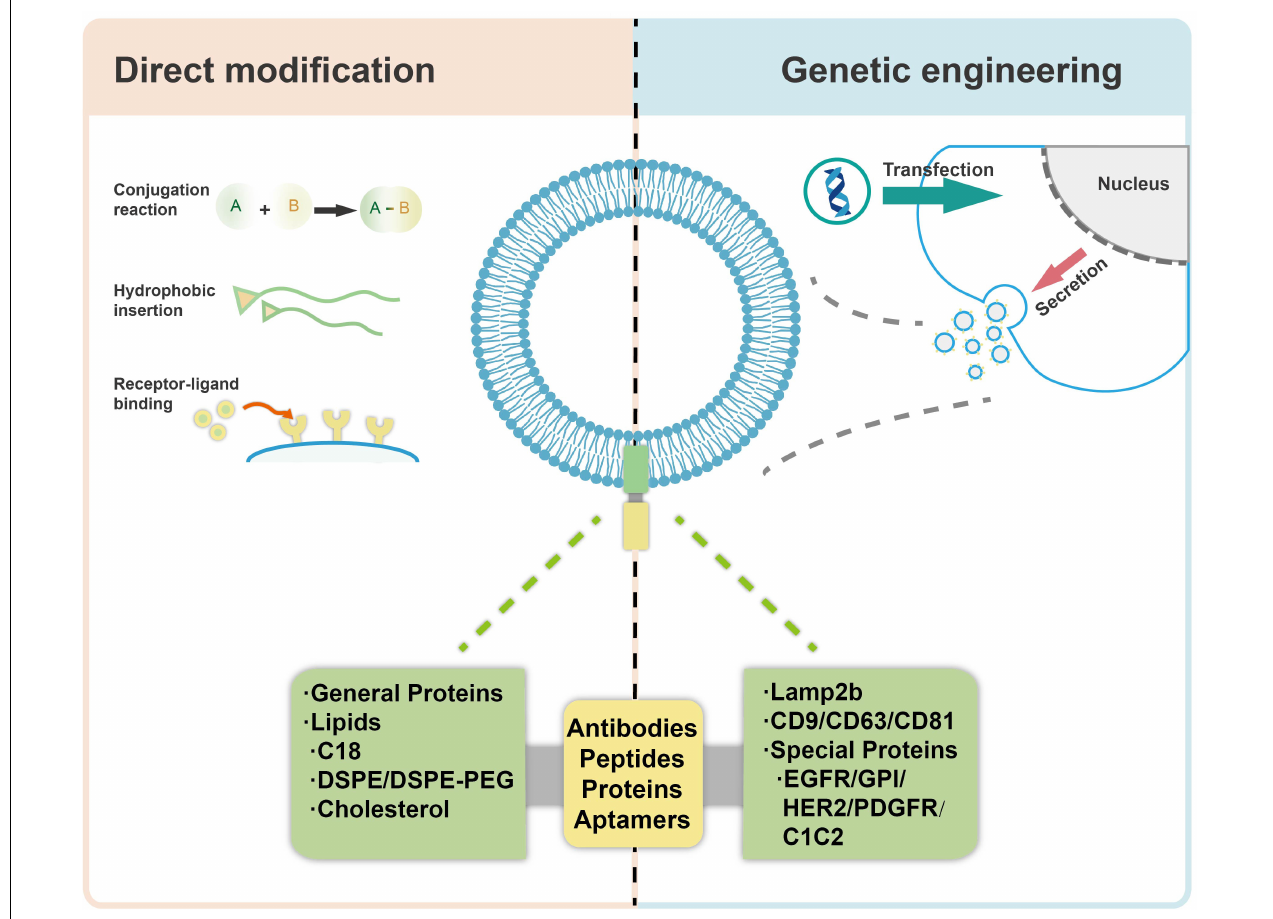
FIGURE 7 | Modification of exosomes for targeted delivery via direct modification and genetic